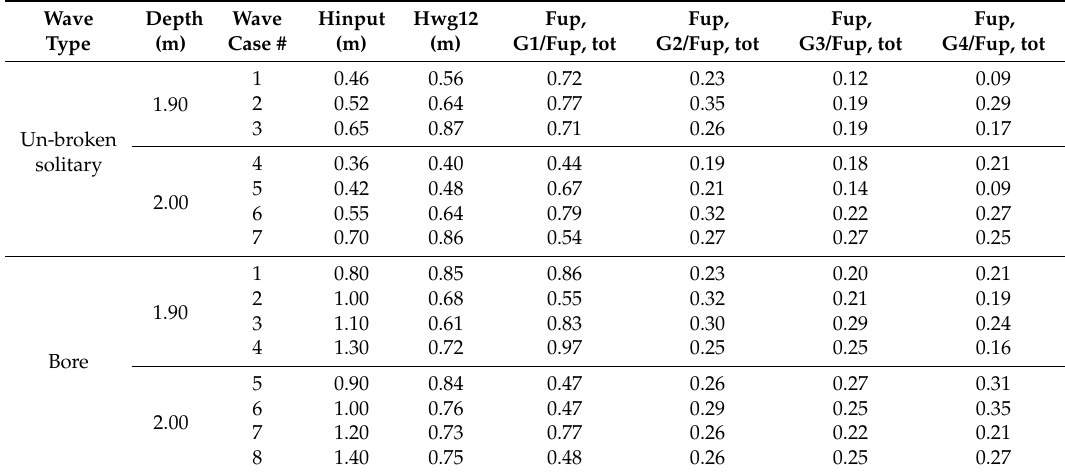
Figure 8. Uplift forces measured in the offshore bearings at time instant of maximum total uplift versus the maximum uplift forces in offshore bearings for all solitary waves ( a ) and bores ( b ), and maximum uplift forces measured in the offshore bearings versus the maximum total uplift for solitary waves ( c ) and bores ( d ). Table 2. Ratio of experimentally recorded maximum uplift forces in each bearing relative to the maximum total uplift.